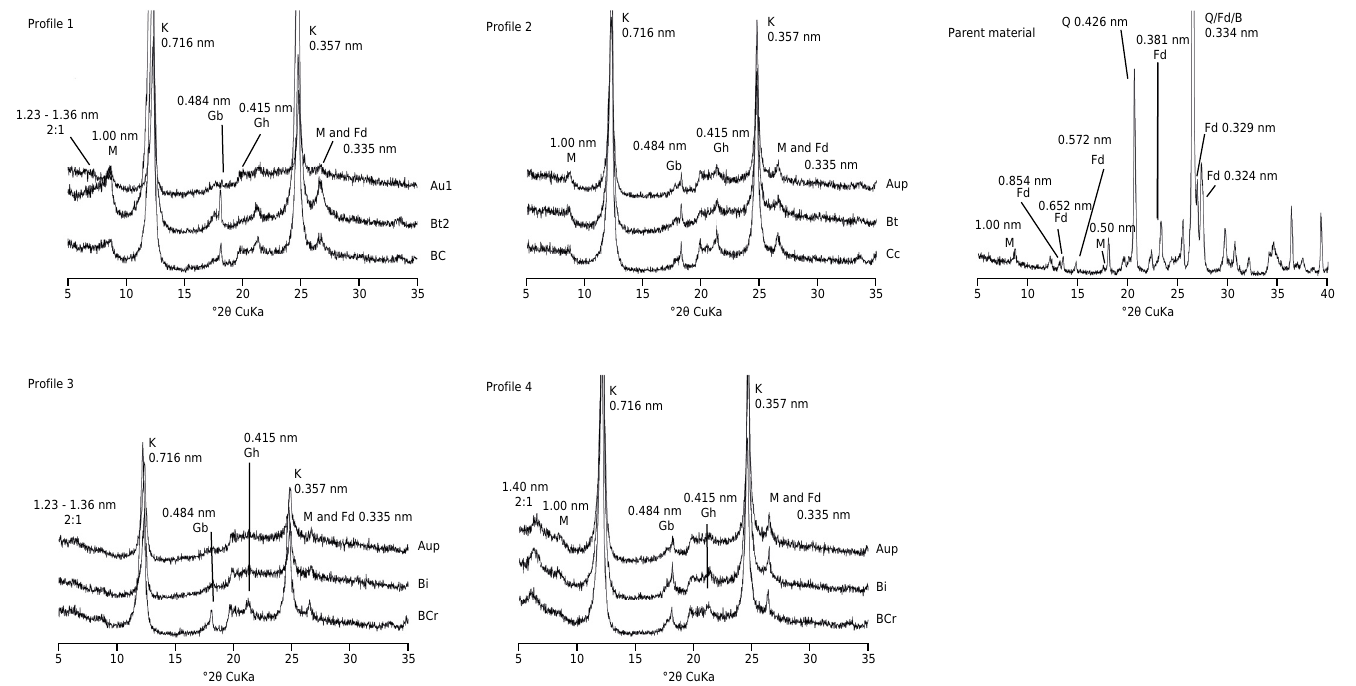
Figure 3. X-ray diffraction (XRD) of the natural clay fraction in the form of oriented aggregates from the A, B, and C horizons/layers and of the parent material. Kaolinite (K), gibbsite (Gb), goethite (Gh), mica (M), feldspars (Fd), smectite (S), vermiculite (V), biotite (B), and quartz